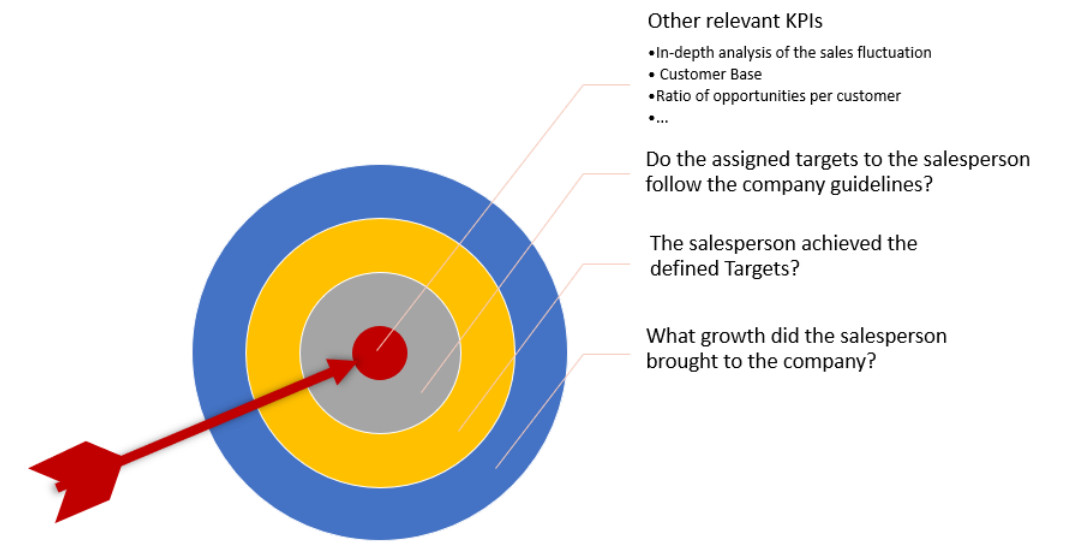
Figure 1. Company’s performance evaluation